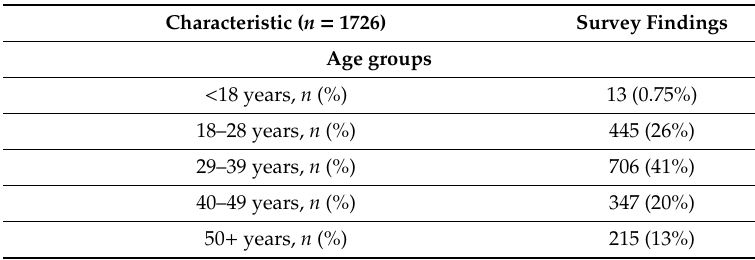
Table 1. Socio-demographic characteristics of study